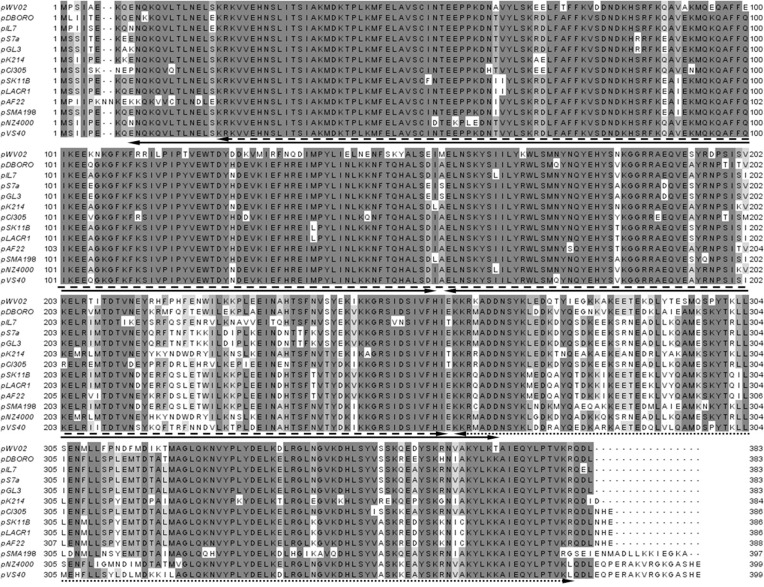
Multiple sequence alignment of RepB sequences relevant to the respective protein of pSMA198.The alignment was performed with ClustalW [23]. Double-headed arrows indicate positions of protein sequence signatures as determined by InterProScan [24], as follows: initiator Rep protein (dashed line), L. lactis RepB C-terminal (dotted line) and two consecutive winged helix-turn-helix transcription DNA-binding repressor (solid line).